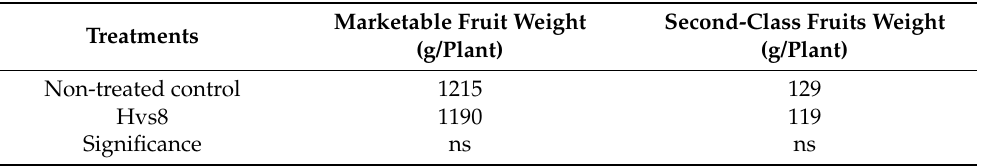
Table 4. Marketable fruit and second-class fruits weights (in grams per plant) of strawberry plants cv. ‘Rociera’ treated with Hvs8 bacterial suspension and non-treated plants (means of 2018/2019 and